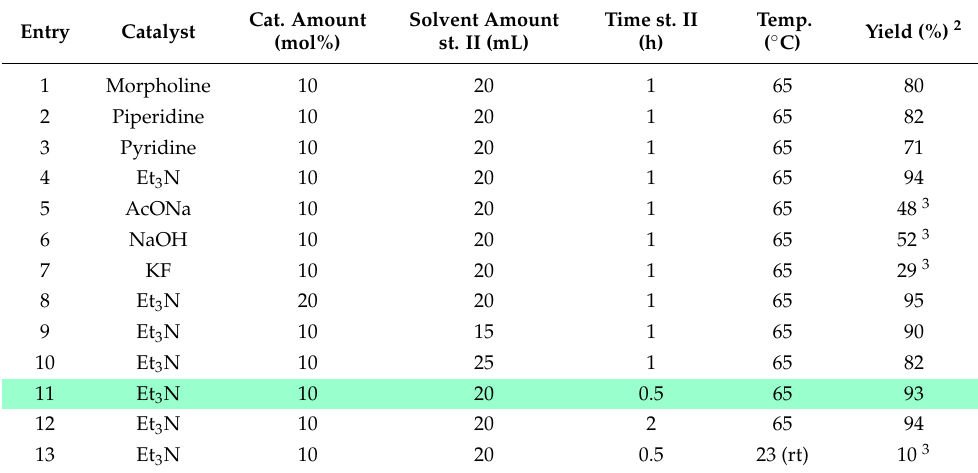
Table 1. Optimization of reaction conditions on the synthesis of 4a 1